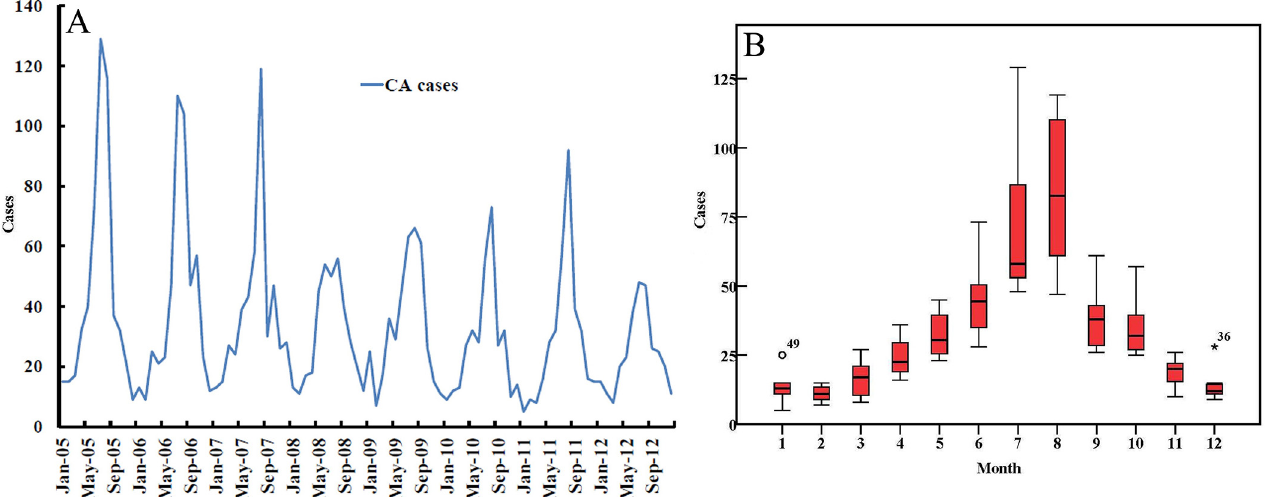
Fig 1. Epidemic curve, seasonal pattern and temporal clusters of human cutaneous anthrax in mainland China, 2005 – 2012. (A)The figure shows epidemic curve of monthly CA cases (blue line) and significant temporal clusters (red line) from 2005 – 2012; (B) The seasonal pattern of CA. The bottom and top of the box represents the lower quartile (P 25 ) and the upper quartile (P 75 ) respectively; the bottom, middle and top line is minimum, median and maximum value; dot and asterisk with number represent value of outlier and extreme outlier,